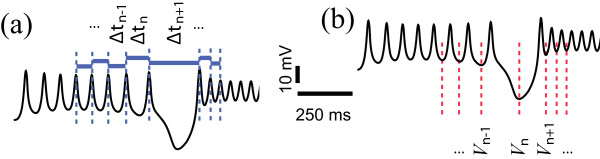
Bursting voltage trace with varying interspike intervals,
Δtn (a) and a sequence of
consecutive minima of the membrane potential, Vn
(b).